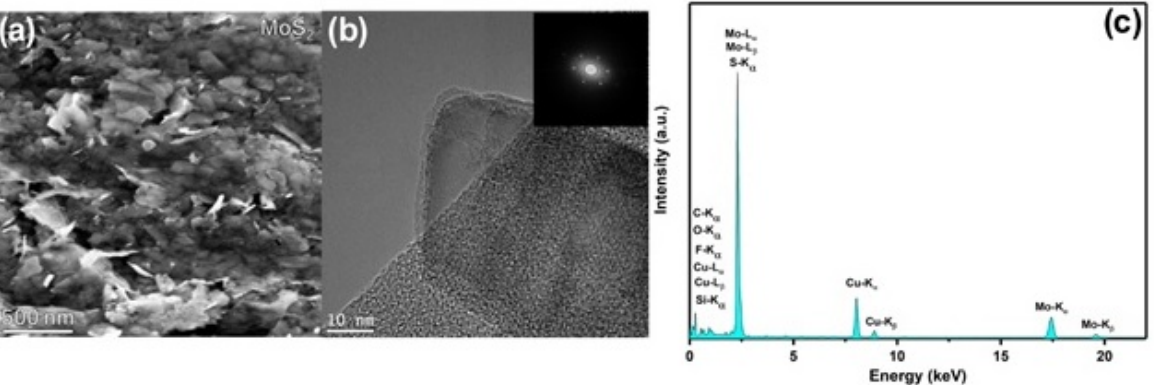
Figure 2. ( a ) SEM image. ( b ) High-resolution TEM images of exfoliated MoS 2 , inset in ( b ) is the fast Fourier transform pattern of exfoliated MoS 2 . ( c ) The EDX spectrum confirms the identity of the nanosheets.